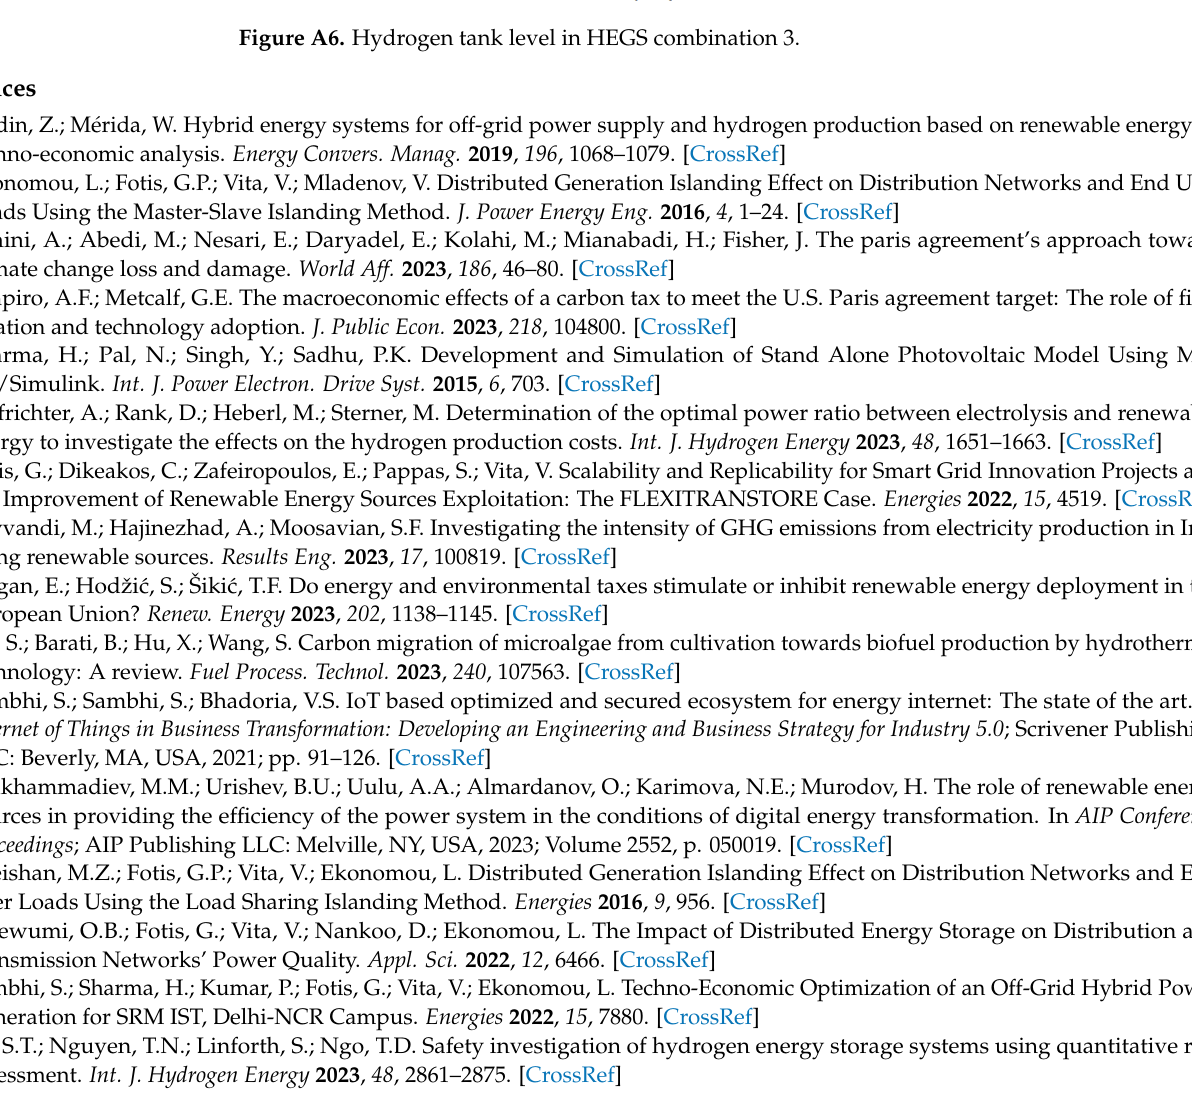
Figure A6. Hydrogen tank level in HEGS combination 3.